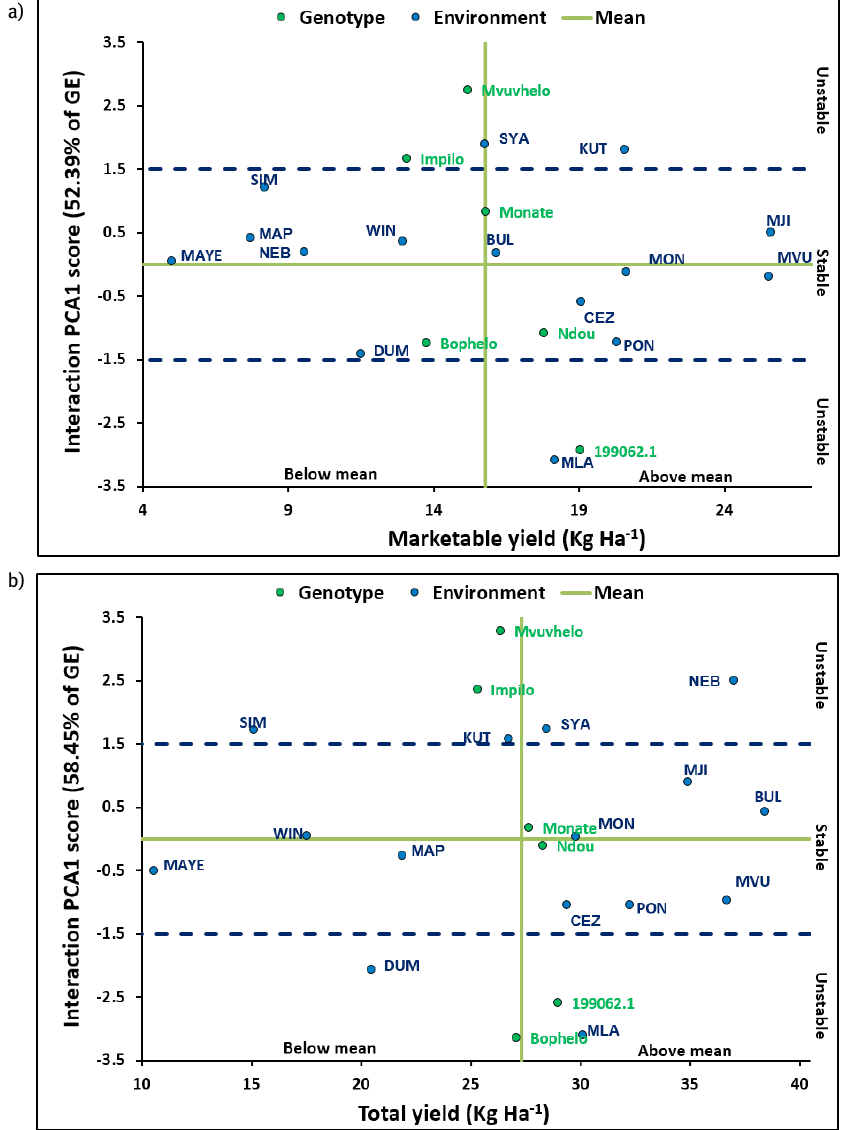
Figure 2: Biplot of IPCA1 versus a) mean marketable storage root yield and b) total storage root yield for six sweet potato cultivars evaluated over 15 sites (Site abbreviations are explained in Table 1) (The cut-off line for stability is indicated in perforated